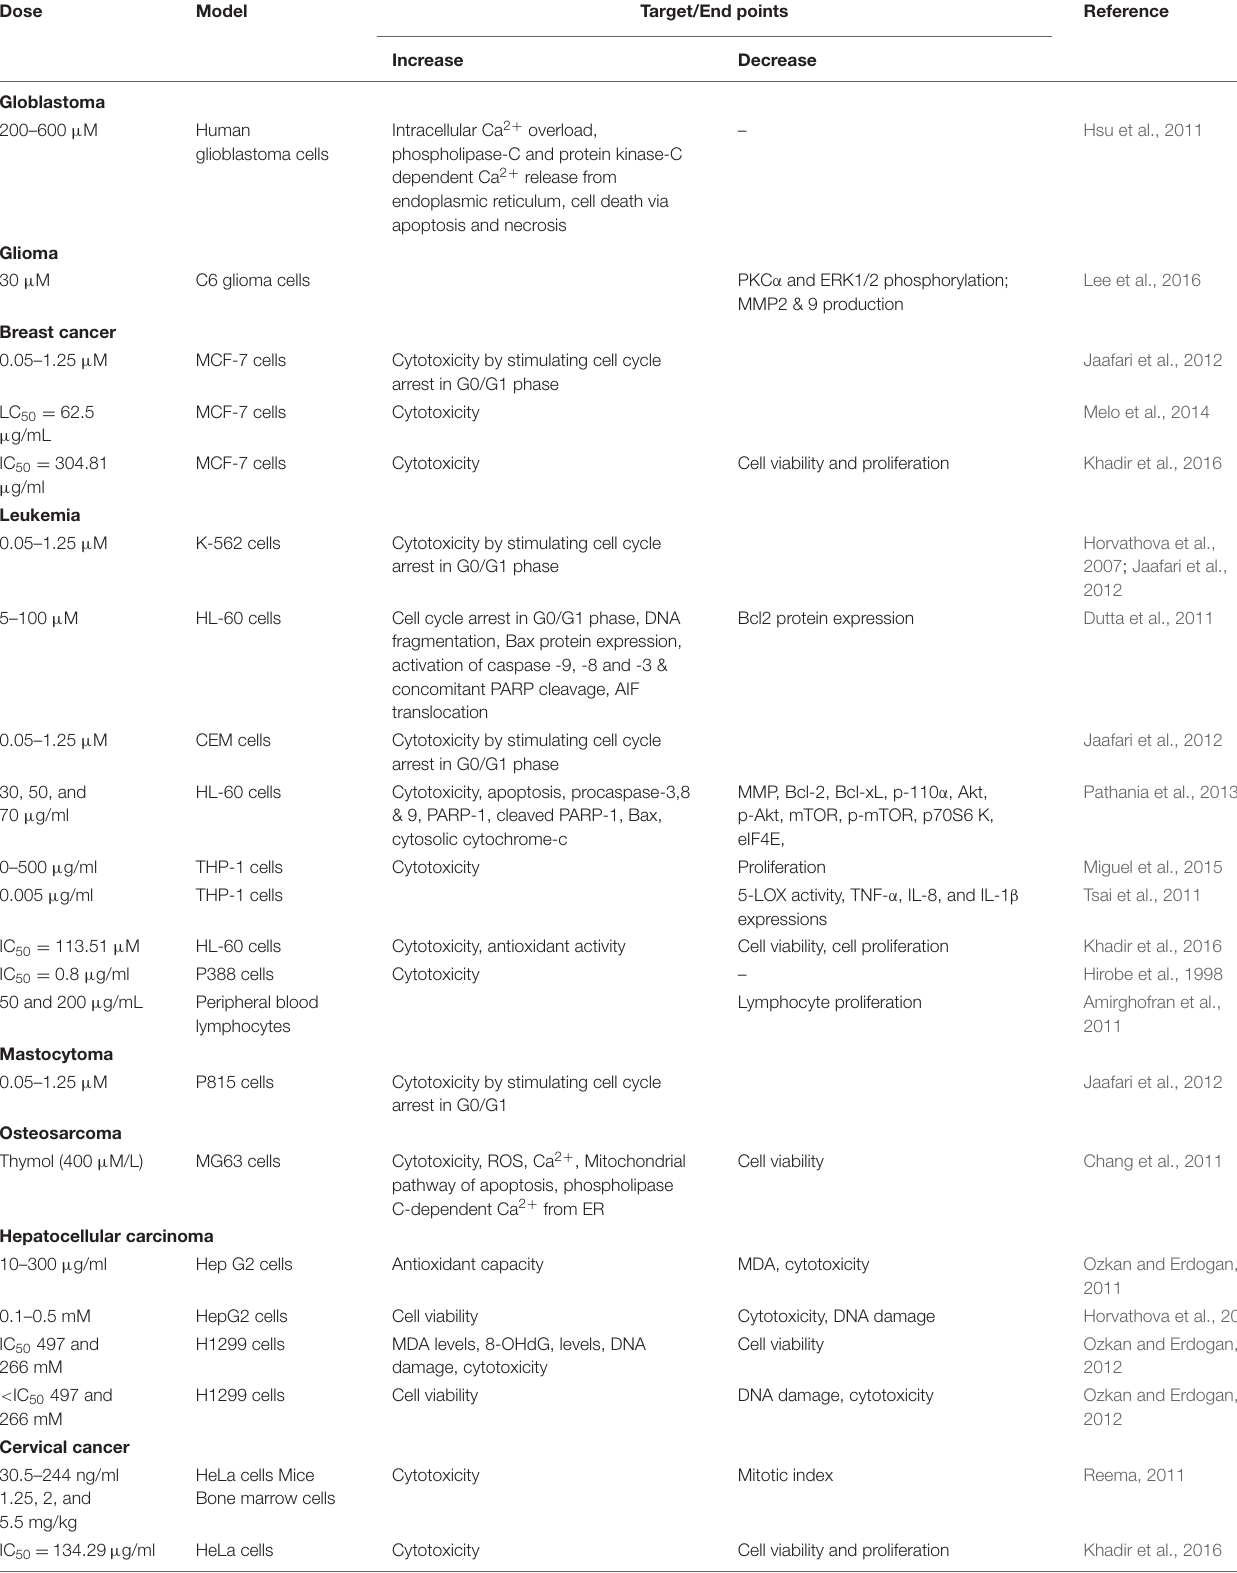
TABLE 1 | Effects of thymol in different experimental models of